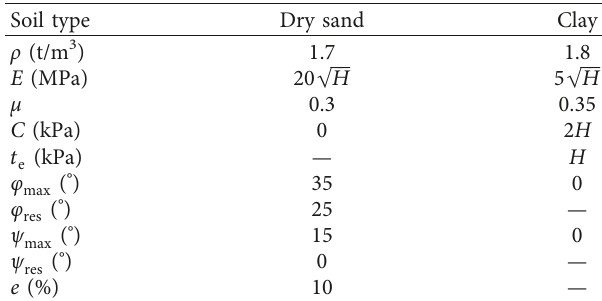
Table 1: The soil